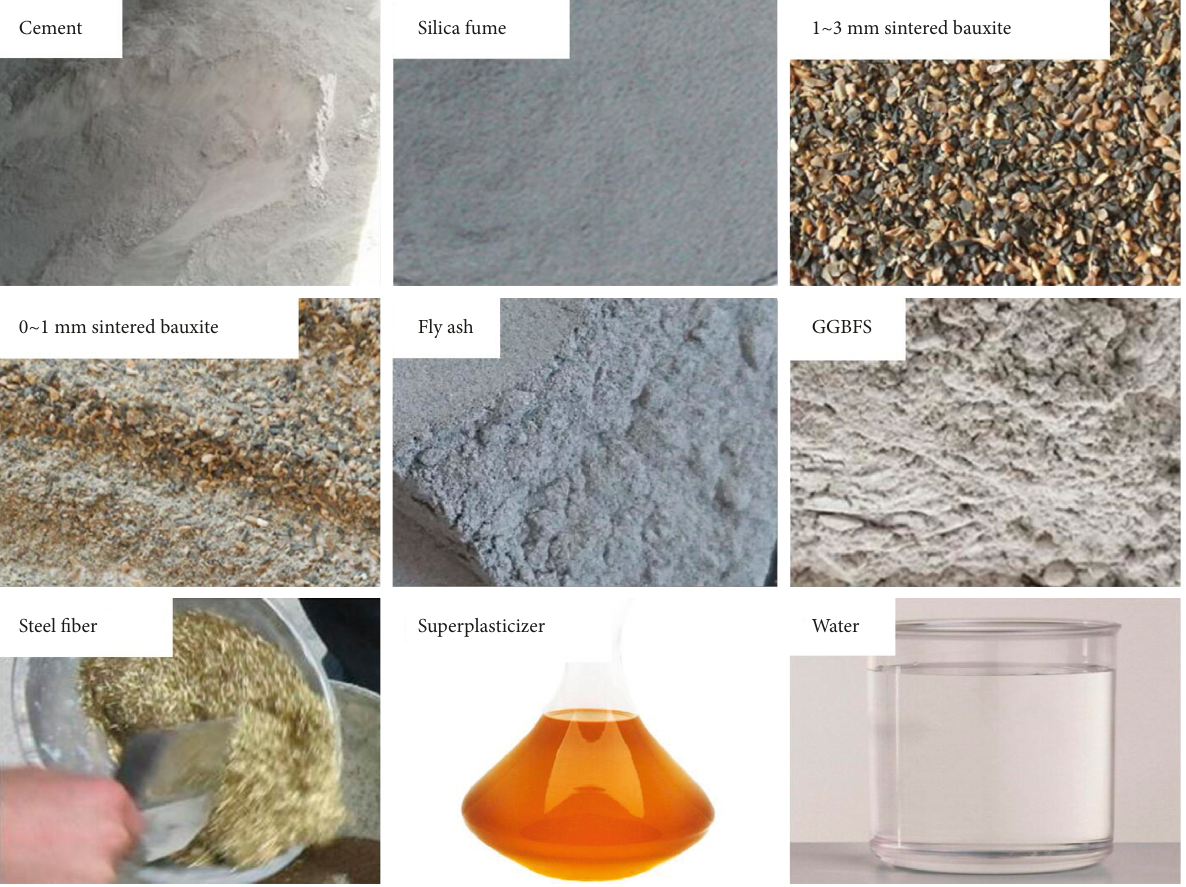
Figure 1: Composition materials of the